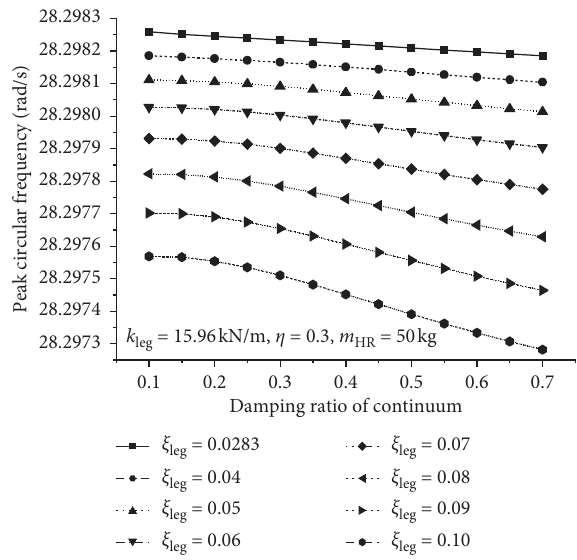
Figure 17: Peak frequency of structure under leg stiffness 15.96kN/m, η � 0 . 3, and m